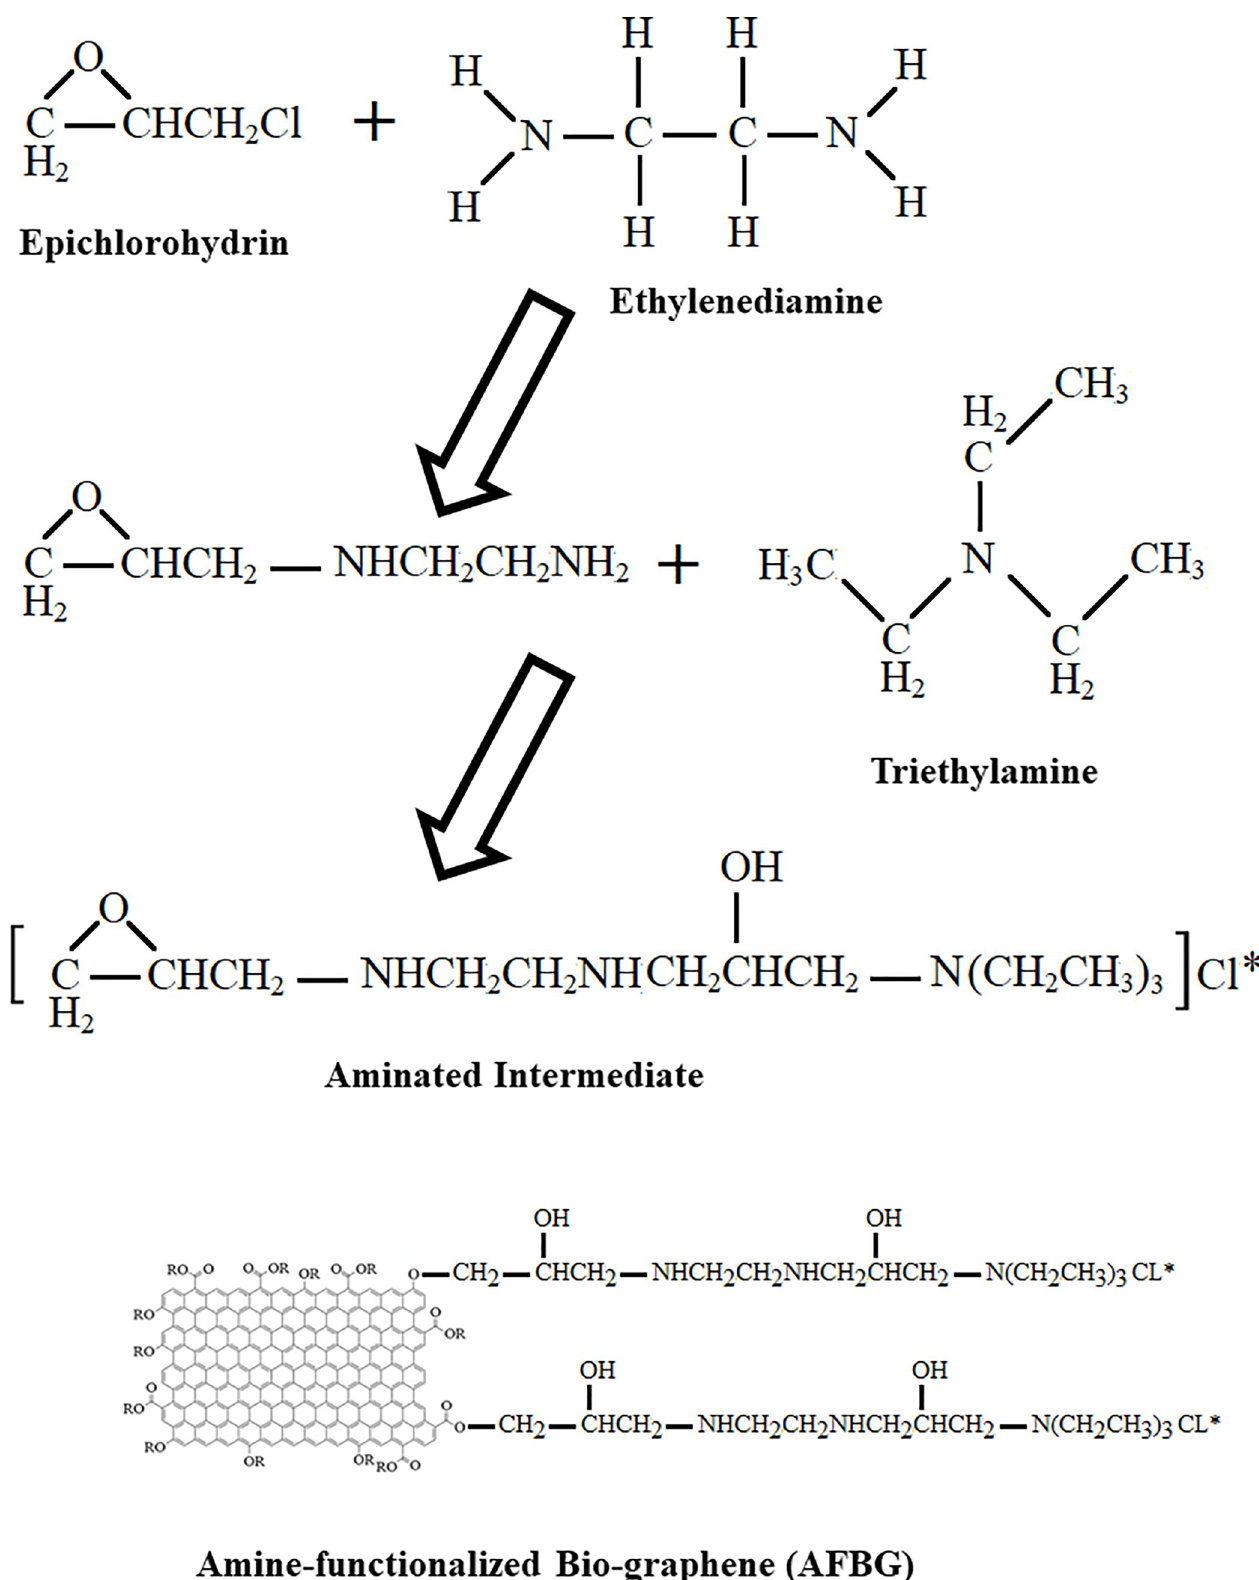
Fig 1. Schematic diagram of amine- modified graphene (AFBG) synthesis. https://doi.org/10.1371/journal.pone.0231045.g001 PLOS ONE | https://doi.org/10.1371/journal.pone.0231045 April 14,